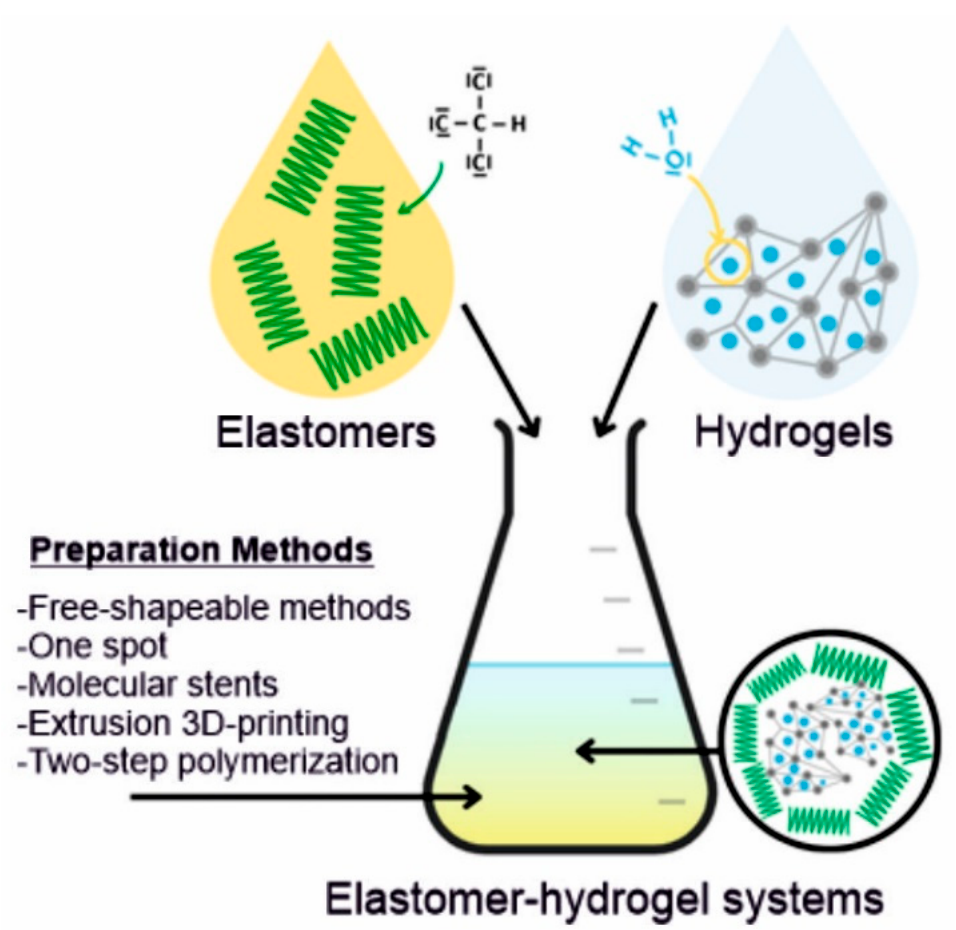
Figure 1. Schematic representation of elastomer–hydrogel systems. Hyphen (-) signs represent free electron pairs.